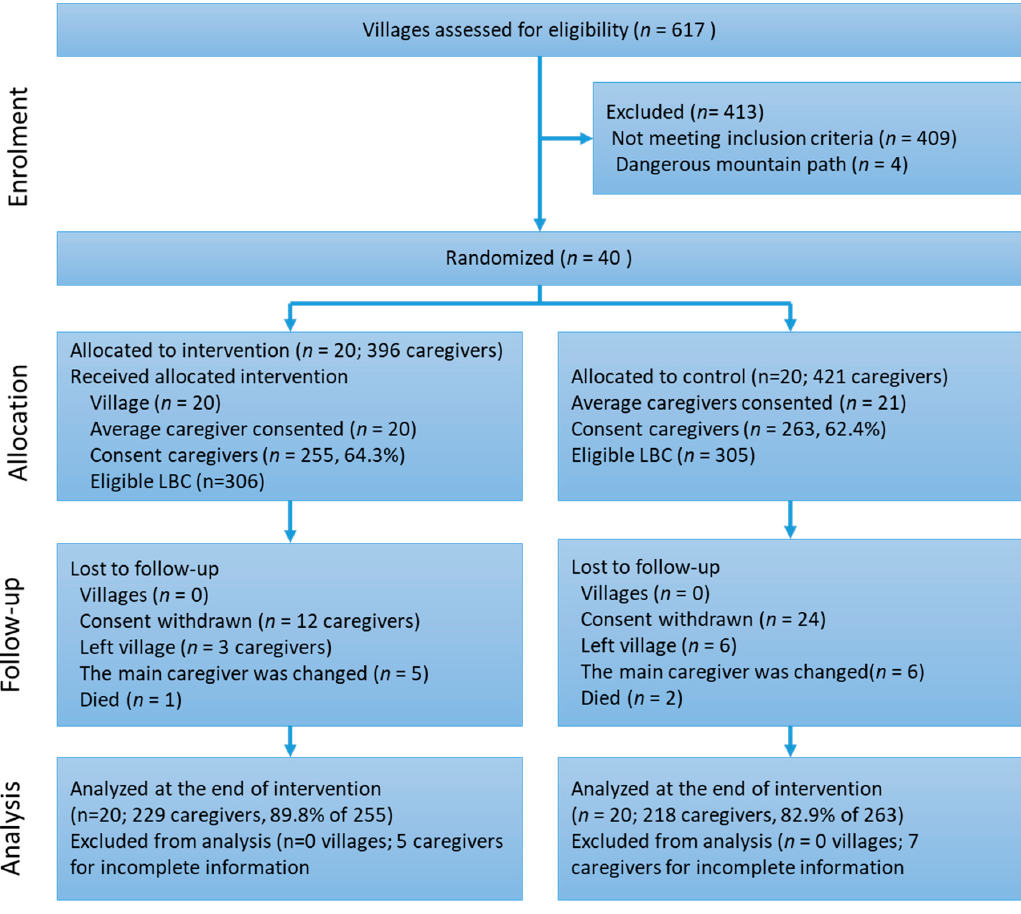
Figure 2. Flow of caregivers’ recruitment and trial allocation Table 2. Comparison of nutritional knowledge between the intervention arm and the control arm of CLBC, at the end of the intervention.